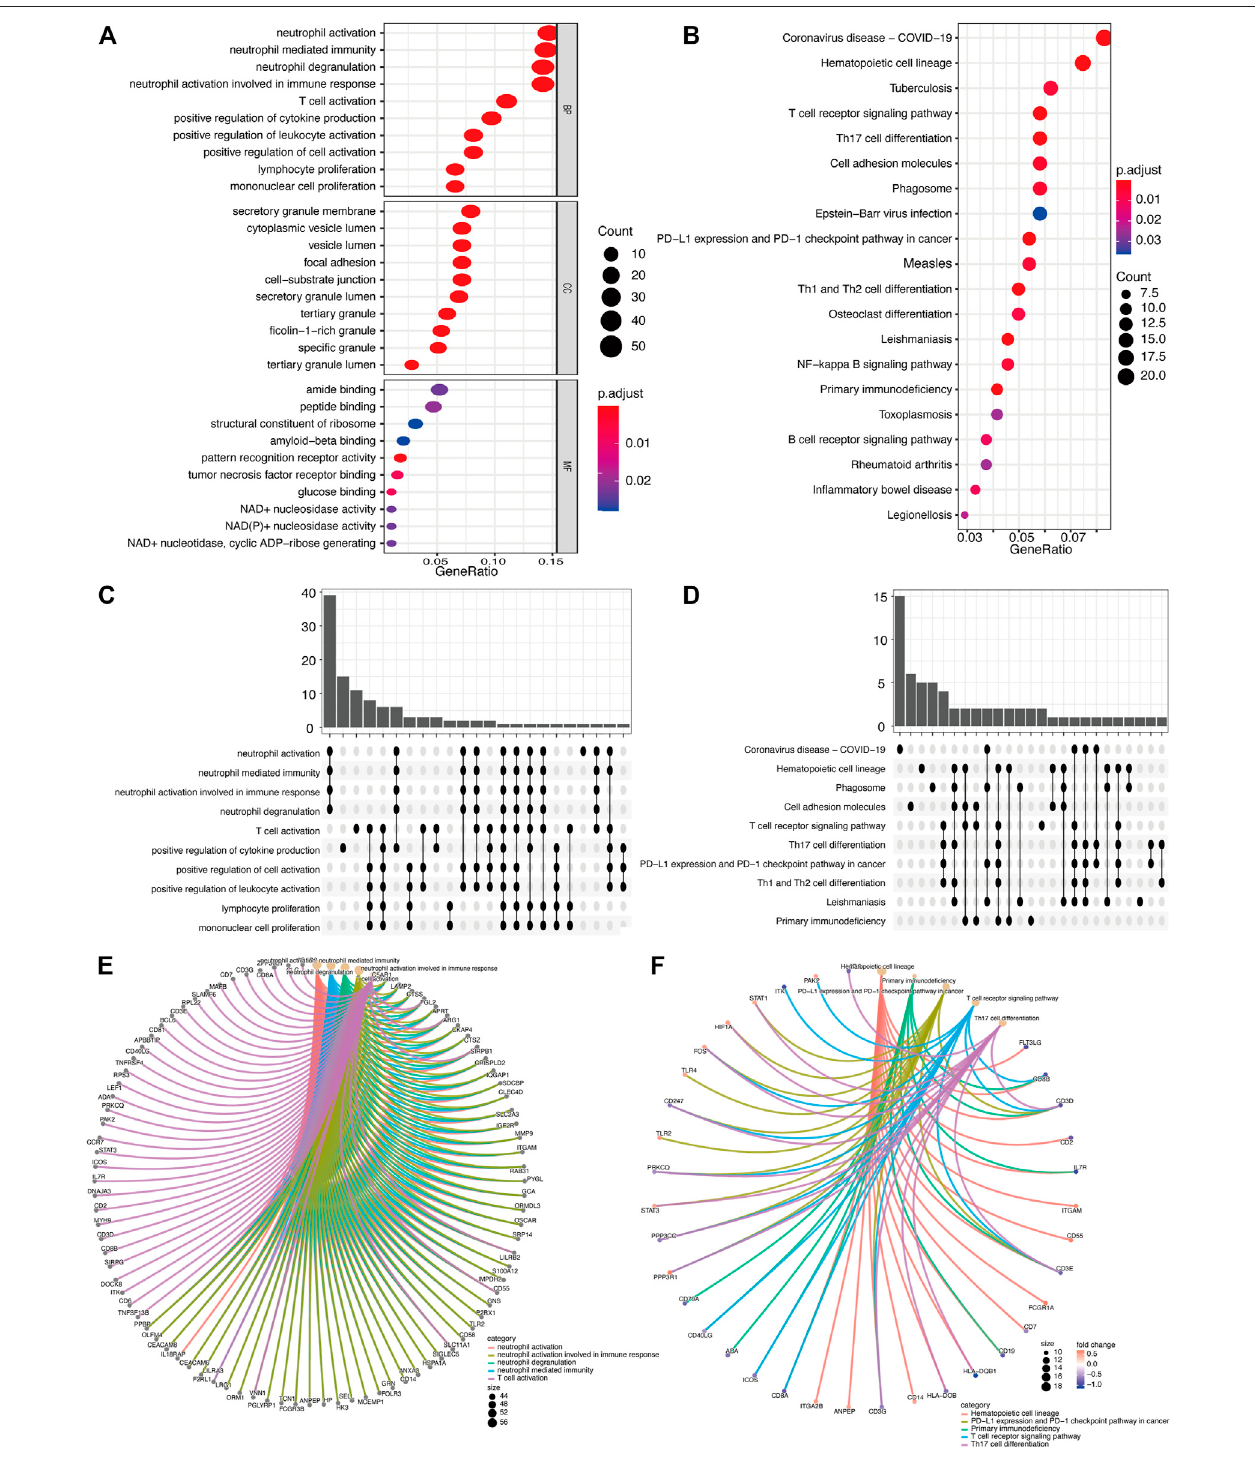
FIGURE 5 | GO/KEGG function enrichment analysis. (A) In GO biological function enrichment analysis, the X horizontal axis represents the proportion of DEGs enriched in GO term, and the color of the dot represents the adjusted p value: the redder the color, the smaller the adjusted p value; the bluer the color, the greater the adjusted p value.ThesizeofthedotrepresentstheamountofenrichedmRNA. (B) InKEGGenrichmentanalysis,theXhorizontalaxisrepresentstheproportionofDEGs, and the color of the dot represents the corrected p value. (C) GO function enrichment analysis upset chart. The horizontal axis represents the categories of term names enriched by DEGs, and the vertical axis represents the number of DEGs in this term. (D) KEGG function enrichment analysis Upset plot. (E) GO function enrichment analysis circos plot. (E) The outer circle is the information of the corresponding entry gene in the enrichment analysis, and the line is the corresponding enrichment term entry. (F) KEGG function enrichment analysis circos